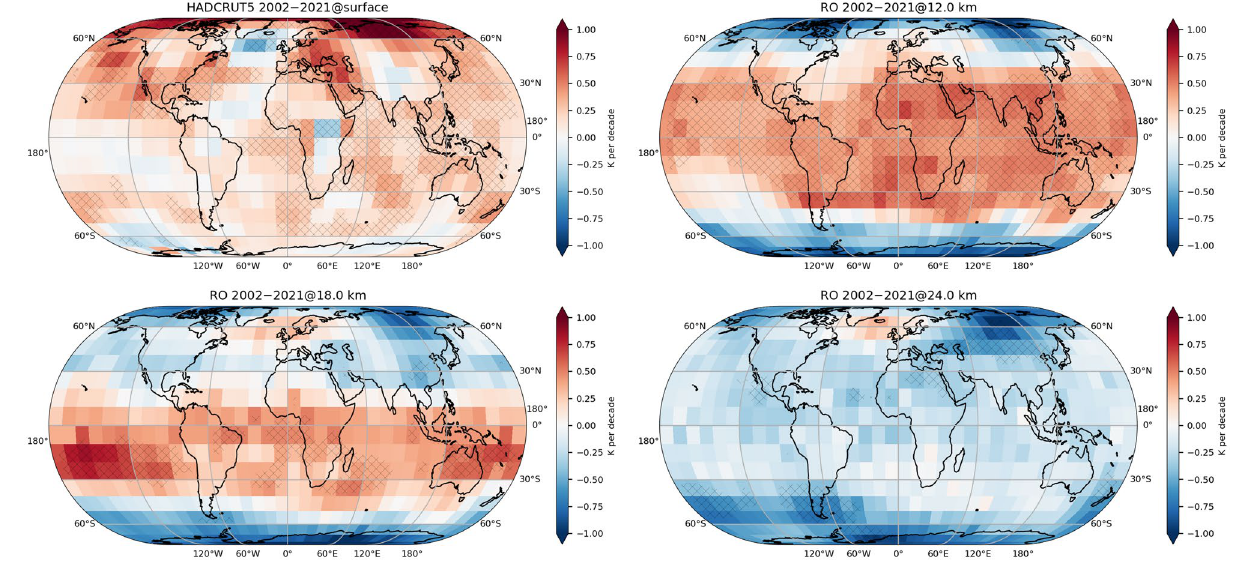
Figure 2. Observed regional temperature trends from the surface to the stratosphere from January 2002 ◦ ◦ to December 2021, in 10 x 10 horizontal resolution. (top left) HadCRUT surface data; GNSS RO data for (top right) 12 km, located in the troposphere in the tropics and stratosphere at high latitudes; (bottom left) stratosphere at 18 km, and (bottom right) stratosphere at 24 km. Areas with trends significant at the 95% level are marked with black crosses. The maps were created using Cartopy v0.20.2 (https:// scito ols. org. uk/ carto